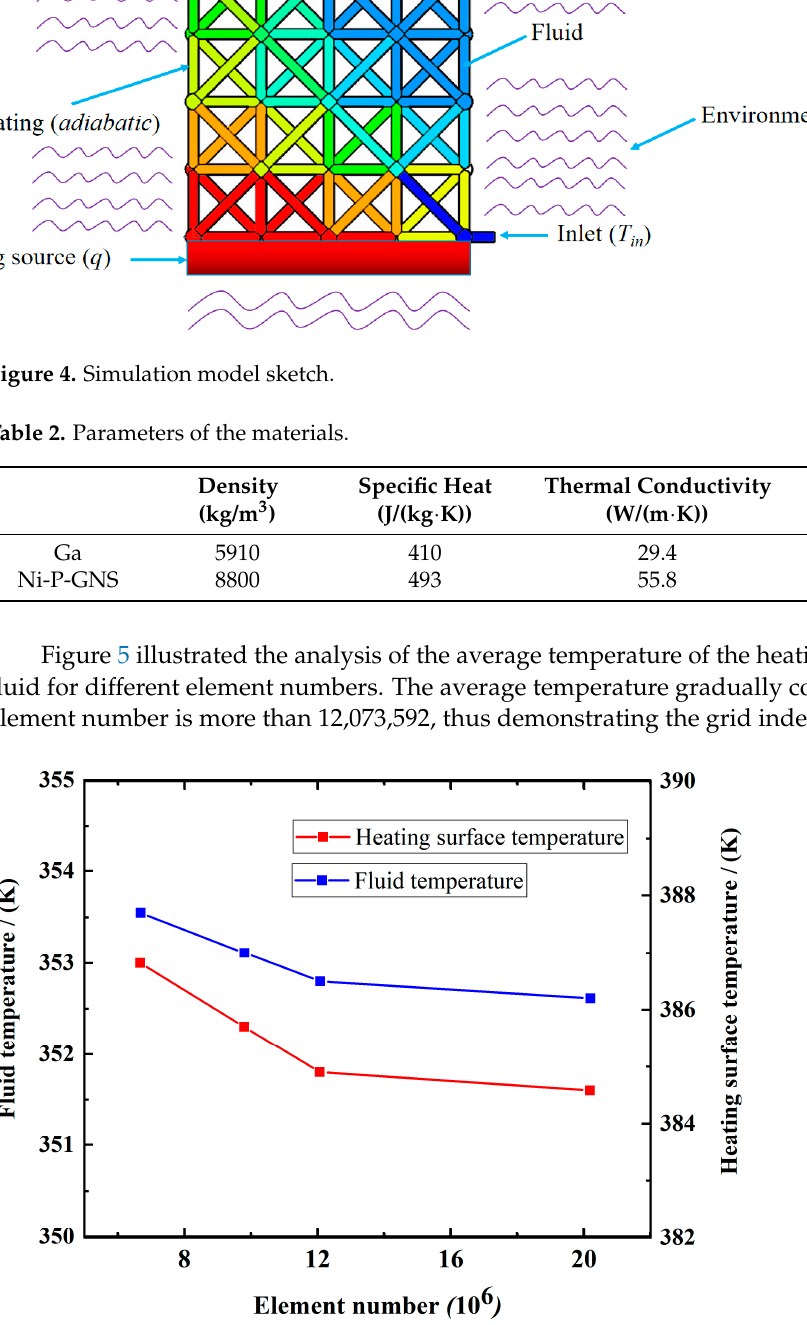
Figure 5. Average temperature of heating surface and fluid for various element numbers.